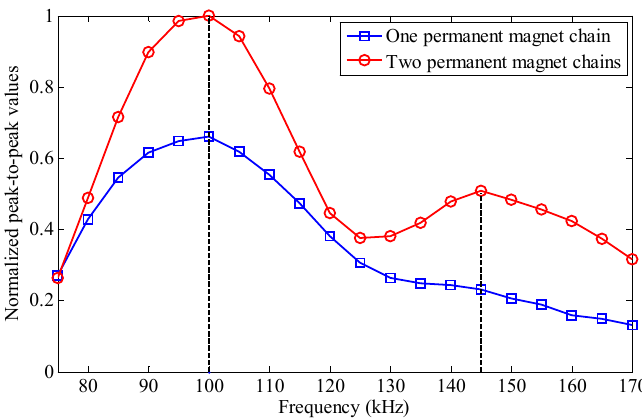
Figure 15. The frequency response features of the proposed EMATs.